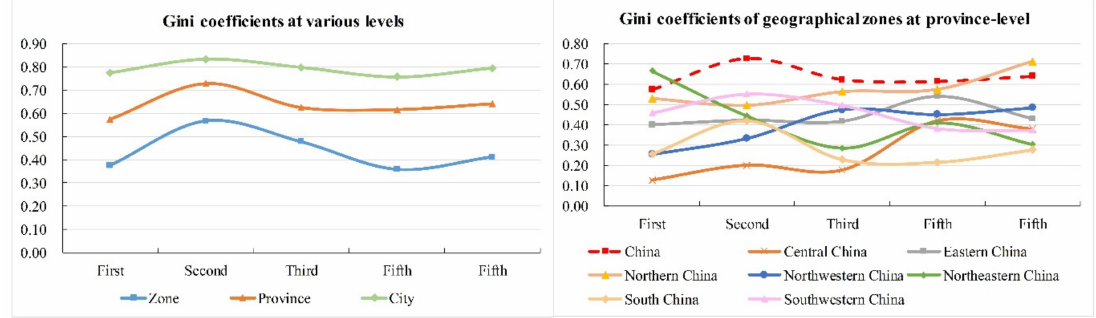
Figure 3. The value of Gini coe ffi cients ( a ) at various levels and ( b ) in seven geographic